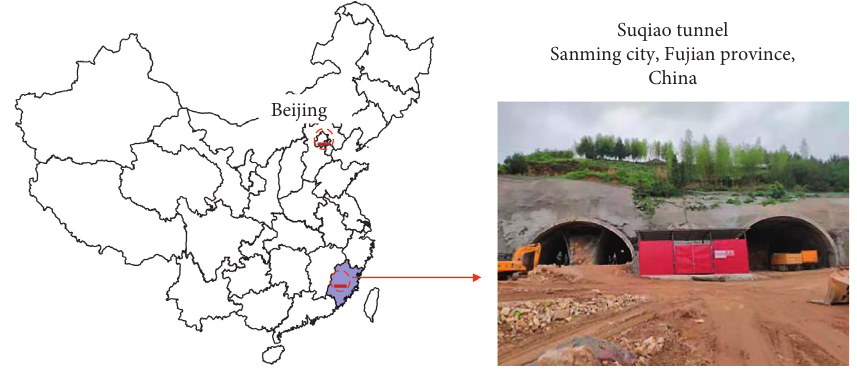
Figure 5: Geographical location of the